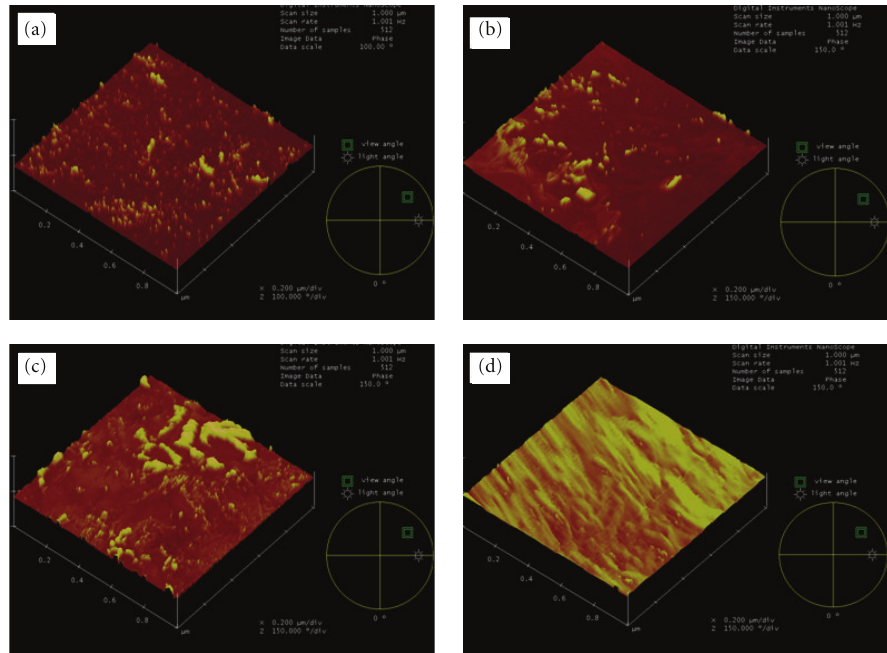
Figure 12: AFM image of (a) CN6F, (b) N6CF2 (film with 2wt% clay), (c) N6CF5 (film with 5wt% clay), and (d) N6CF10 (film with 10wt% clay). (Color figure can be viewed in the online